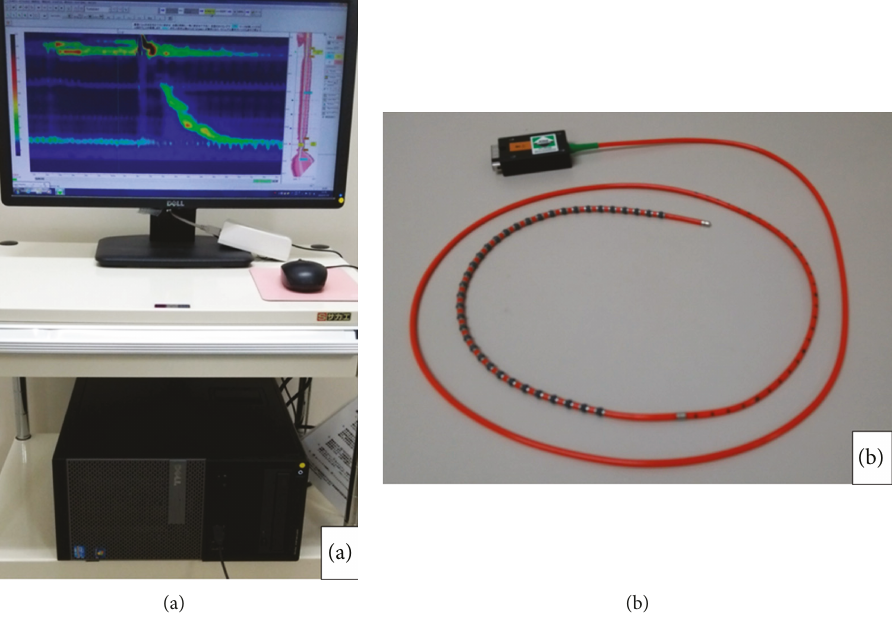
Figure 3: High-resolution manometry (HRM) system. HRM was performed using (a) a Starlet system (Star Medical Inc., Tokyo, Japan) with (b) a catheter (Unisensor AG, Attikon, Switzerland). There were sensor monitors every 1cm.